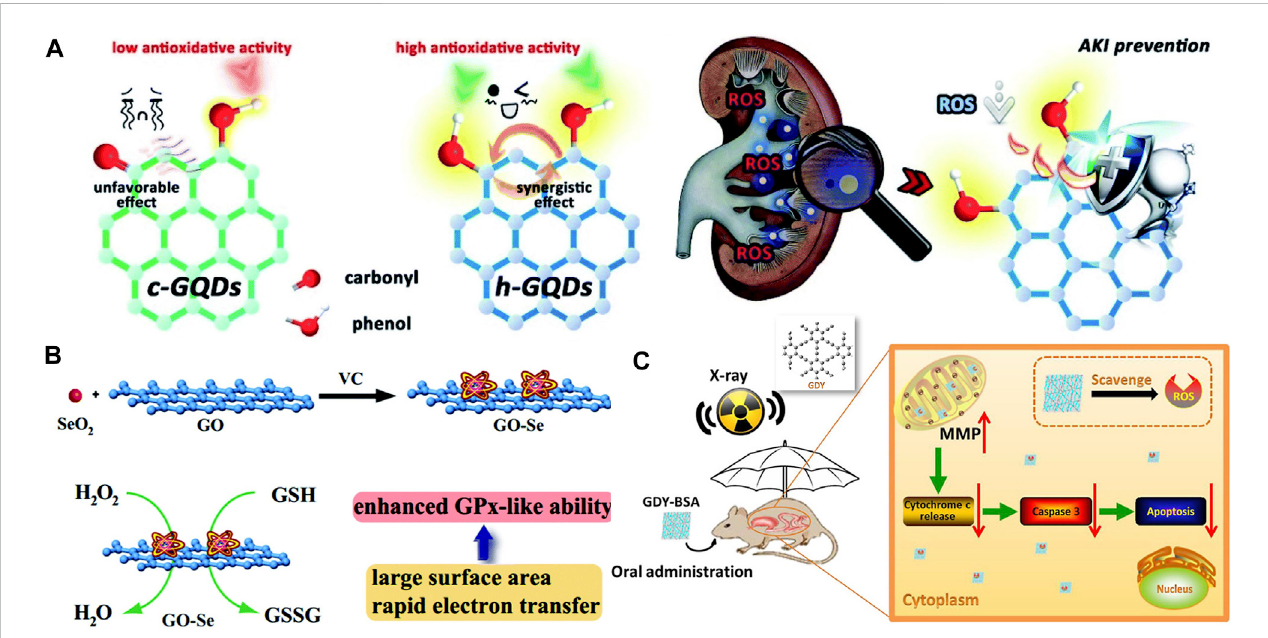
FIGURE 2 (A) Usageofphenol-likegroupfunctionalizedgraphenequantumdots(h-GQDs)forthetreatmentofacutekidneyinjury(Wangetal.,2020b). (B)